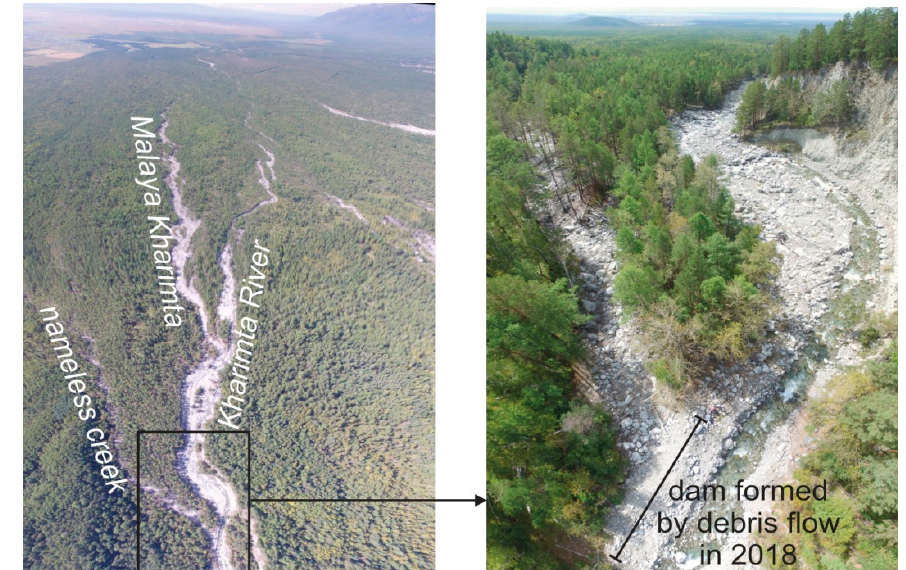
Figure 15. Reconstruction of the river network after the descent of debris flows on the Kharimta and Malaya Kharimta rivers in 2014 and 2018 (Tunkinskie Gol’tsy Range). 51°54 ′ 1.44 ″ N, 102°30 ′ 55.04 ″ E. The image was taken on 1 September 2018.